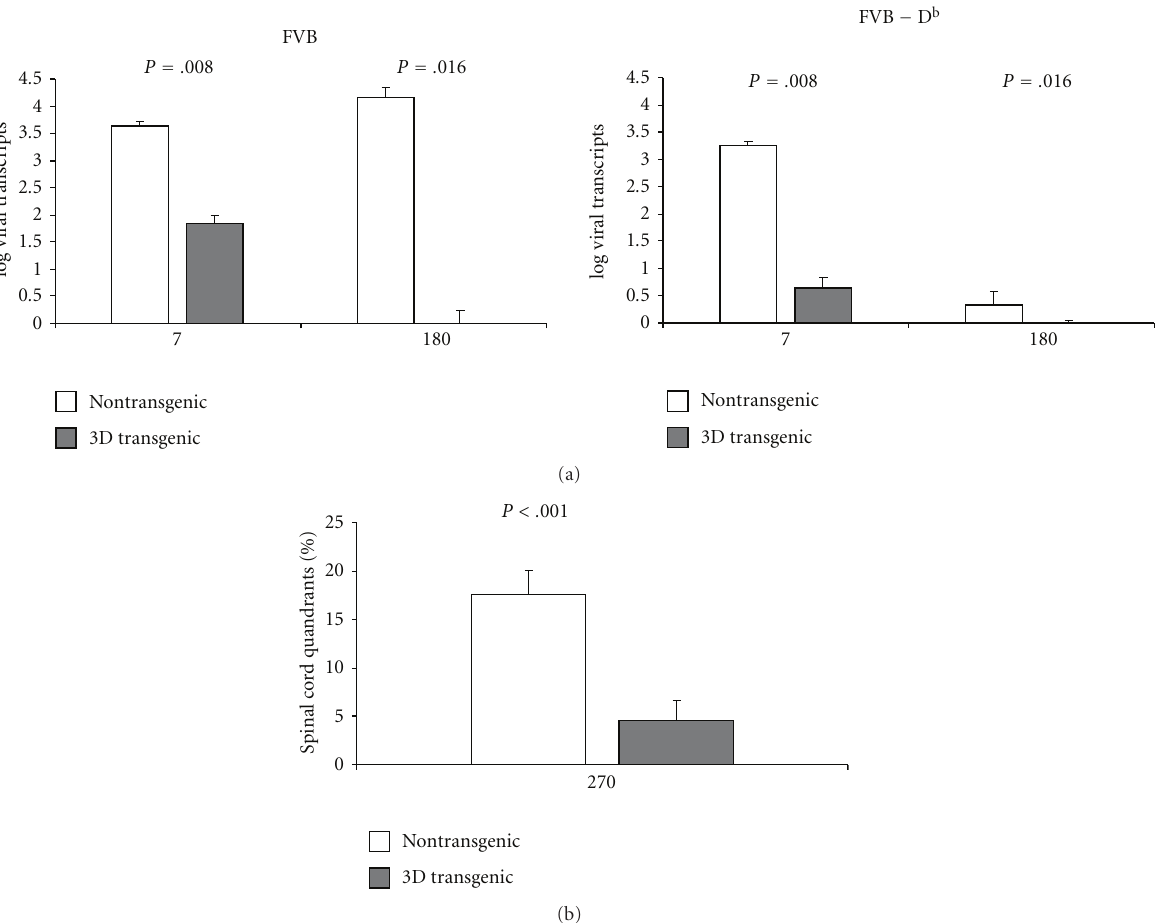
Figure 3: Viral transcripts and demyelination in mice infected with TMEV. (a) Nontransgenic and 3D transgenic mice were infected with 2 × 10 5 plaque forming units of TMEV intracerebrally. Brain and spinal cord were harvested after 7 and 180 days and total RNA was isolated using Trizol reagent (Invitrogen). Viral transcripts for TMEV were quantified by real-time RT-PCR using primers specific for the VP2 region of TMEV. Data are expressed as mean relative viral transcripts + SEM ( n = 5 for nontransgenic and 5 for 3D transgenic) in the brain or spinal cord above uninfected mice and were normalized to GAPDH. (b) Percent of spinal cord quadrants containing demyelinated lesions in 3D transgenic and nontransgenic FVB mice at 270 days after infection. Statistical significance was determined using the Mann-Whitney rank sum